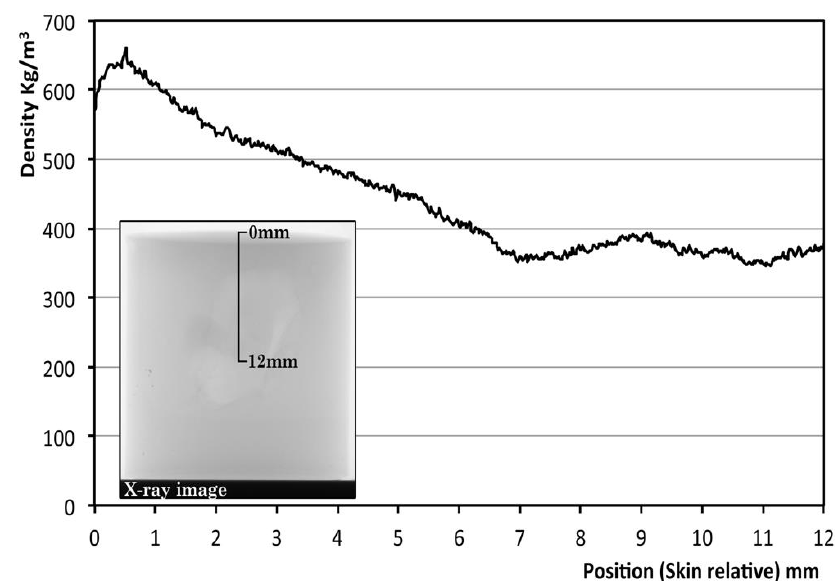
Figure 6. Internal density of one foam of 0.5 relative density, from the top to the center of the foam in the direction of the axis of the cylinder. The density is obtained by the intensity of grey in the X-ray image.